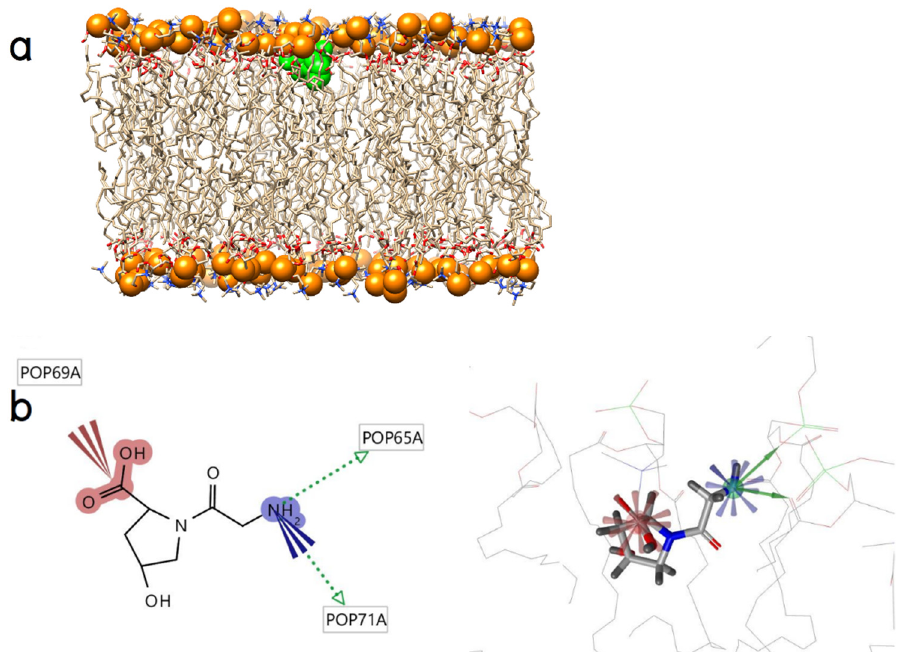
Figure 4. ( a ) An initial position of Gly-Hyp (green surface) and ( b ) its binding modes (the green arrows represent hydrogen bond donors, the blue spherical star represents a positive ionizable area, and the red spherical star represents a negative ionizable area).